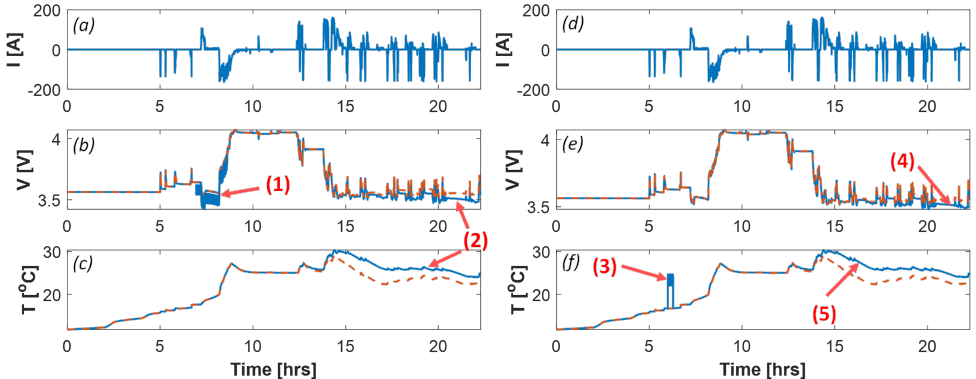
Figure 3. Examples of nominal (dashed) and synthetic anomalous (solid) voltage ( b , e ) and tempera- ture ( c , f ) data associated with (1) loose voltage sense lead, (2) ISC, (3) loose temperature sense lead, (4) voltage dropout, and (5) air–flow anomaly, with the input current ( a , d